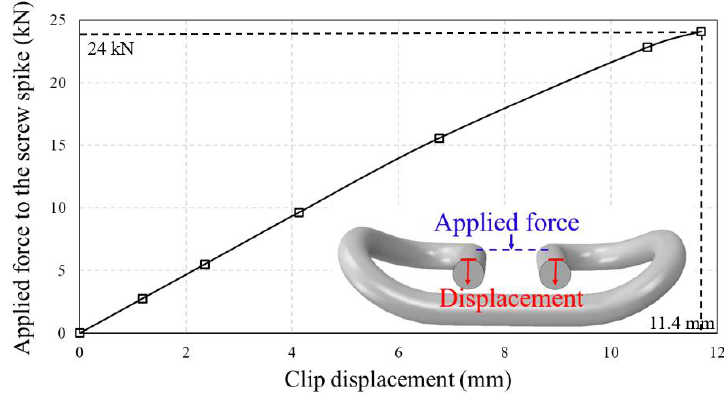
Figure 11. Global response of the clip (force vs. displacement).